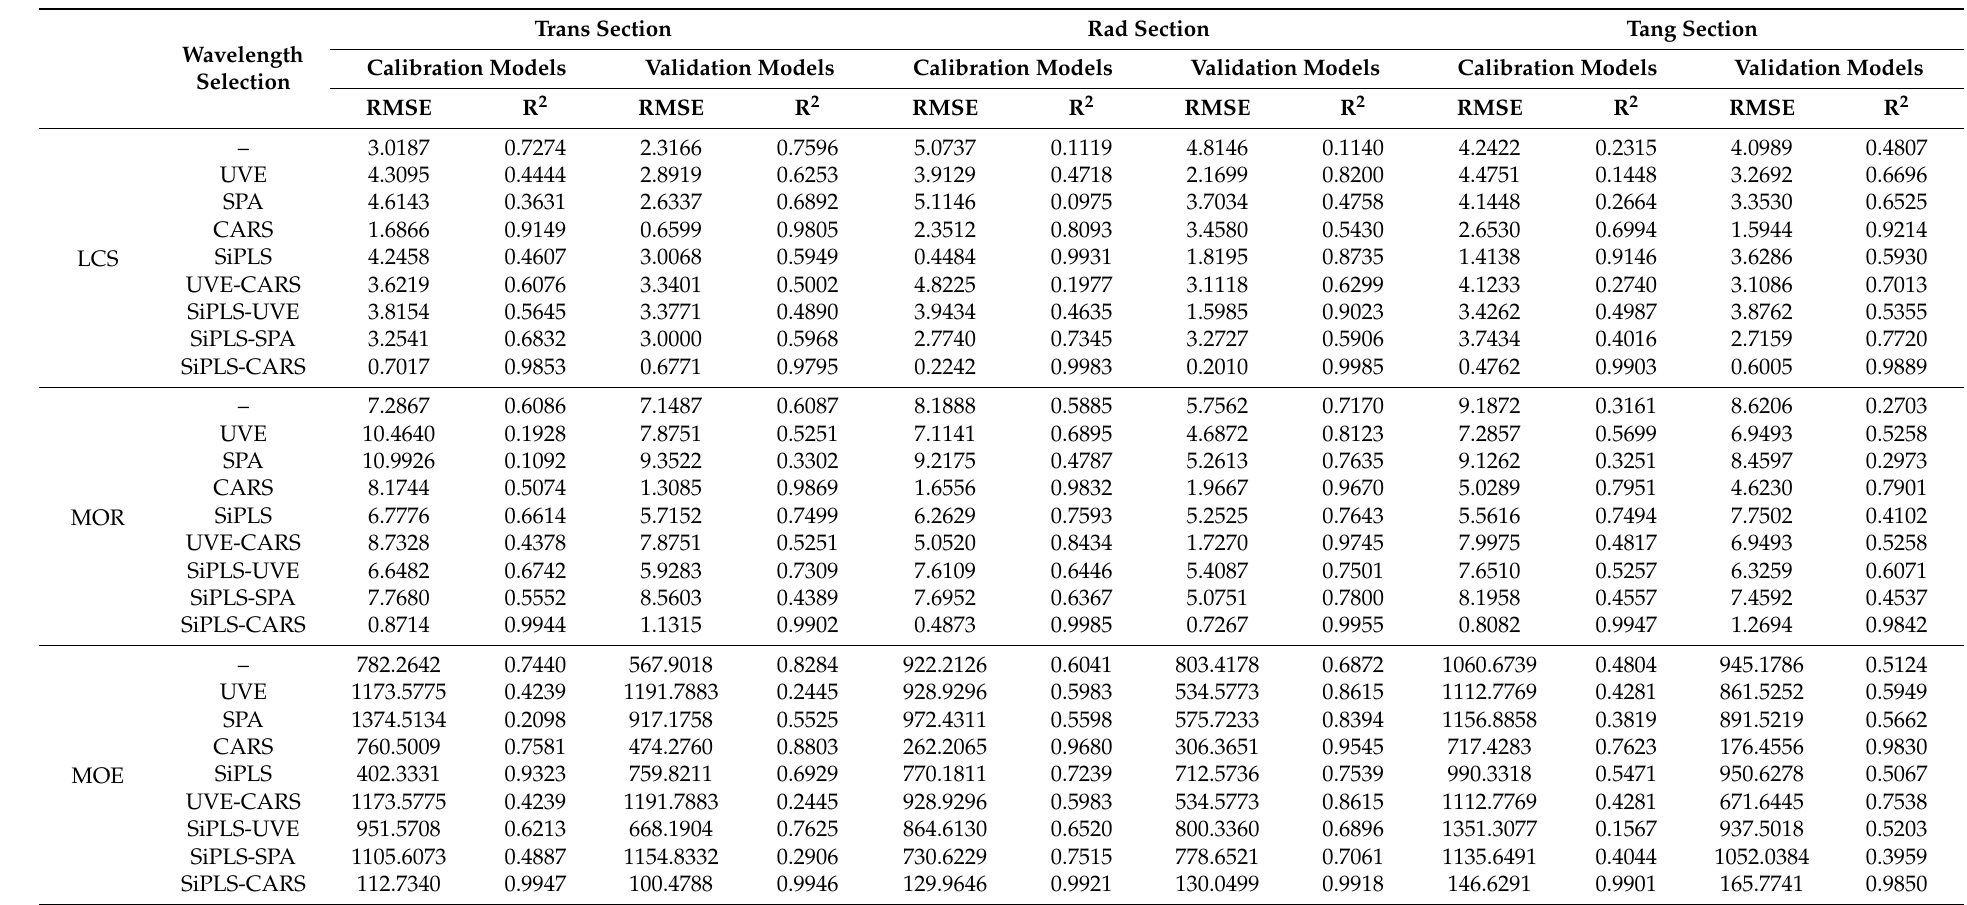
Table 3. PLSR modeling results of different variable selection